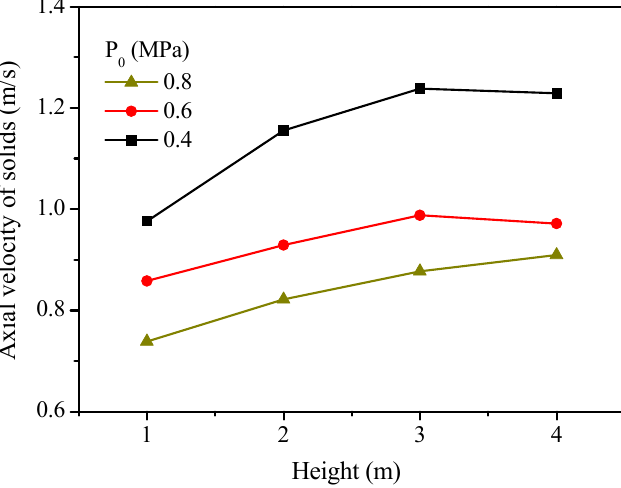
Figure 14. Distribution of axial velocities of solids with different pressures as a function of height.